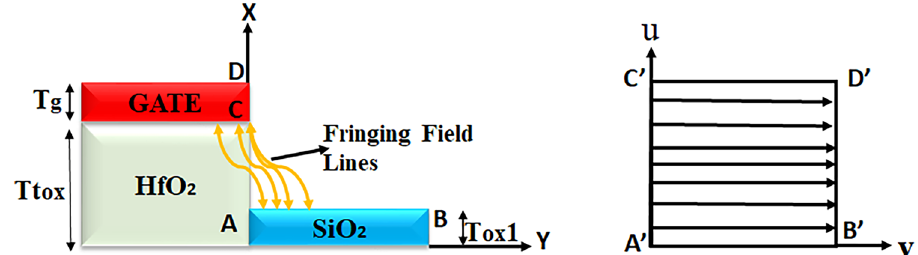
Figure 17. Cross-section of the Device structure 1 (Fig. 1a) showing the fringing field lines and the structural